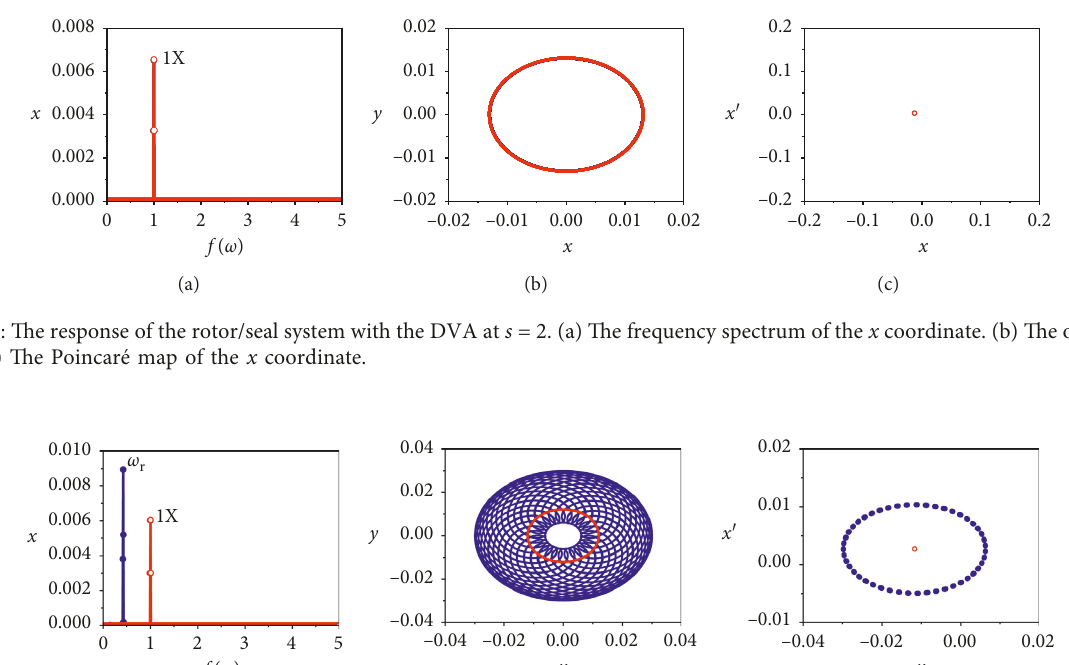
Figure 8: The 14T-periodic response of the rotor/seal system at s rotor. (c) The Poincar´e map of the x coordinate.